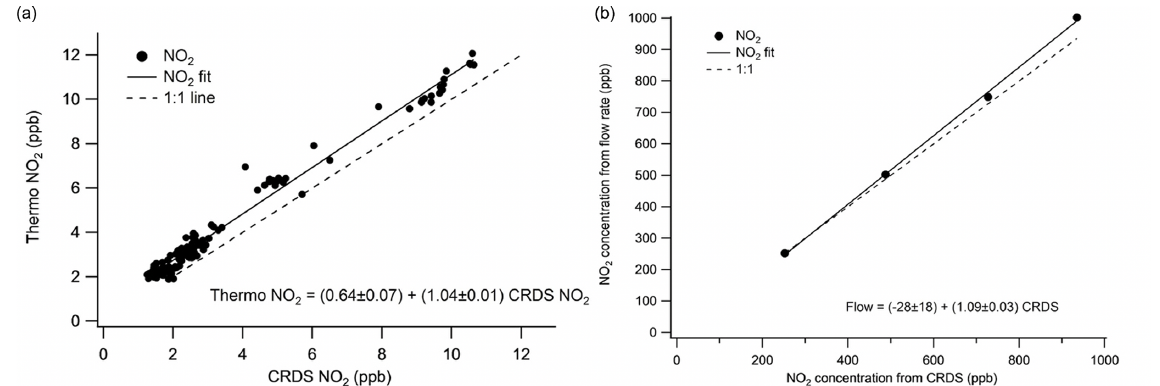
Figure 3. (a) Low-concentration NO 2 comparison of Los Gatos Research NO 2 cavity ring-down spectrometer to a thermo chemiluminescent NO x box. The dashed line represents a 1 : 1 relationship. The slope of the fitted line is 1 . 04 ± 0 . 01. (b) High-concentration NO 2 comparison of LGR cavity ring-down spectrometer to concentrations calculated using flow rates. The dashed line is a 1 : 1 relationship. The slope of the fitted line is 1 . 09 ± 0 . 03.